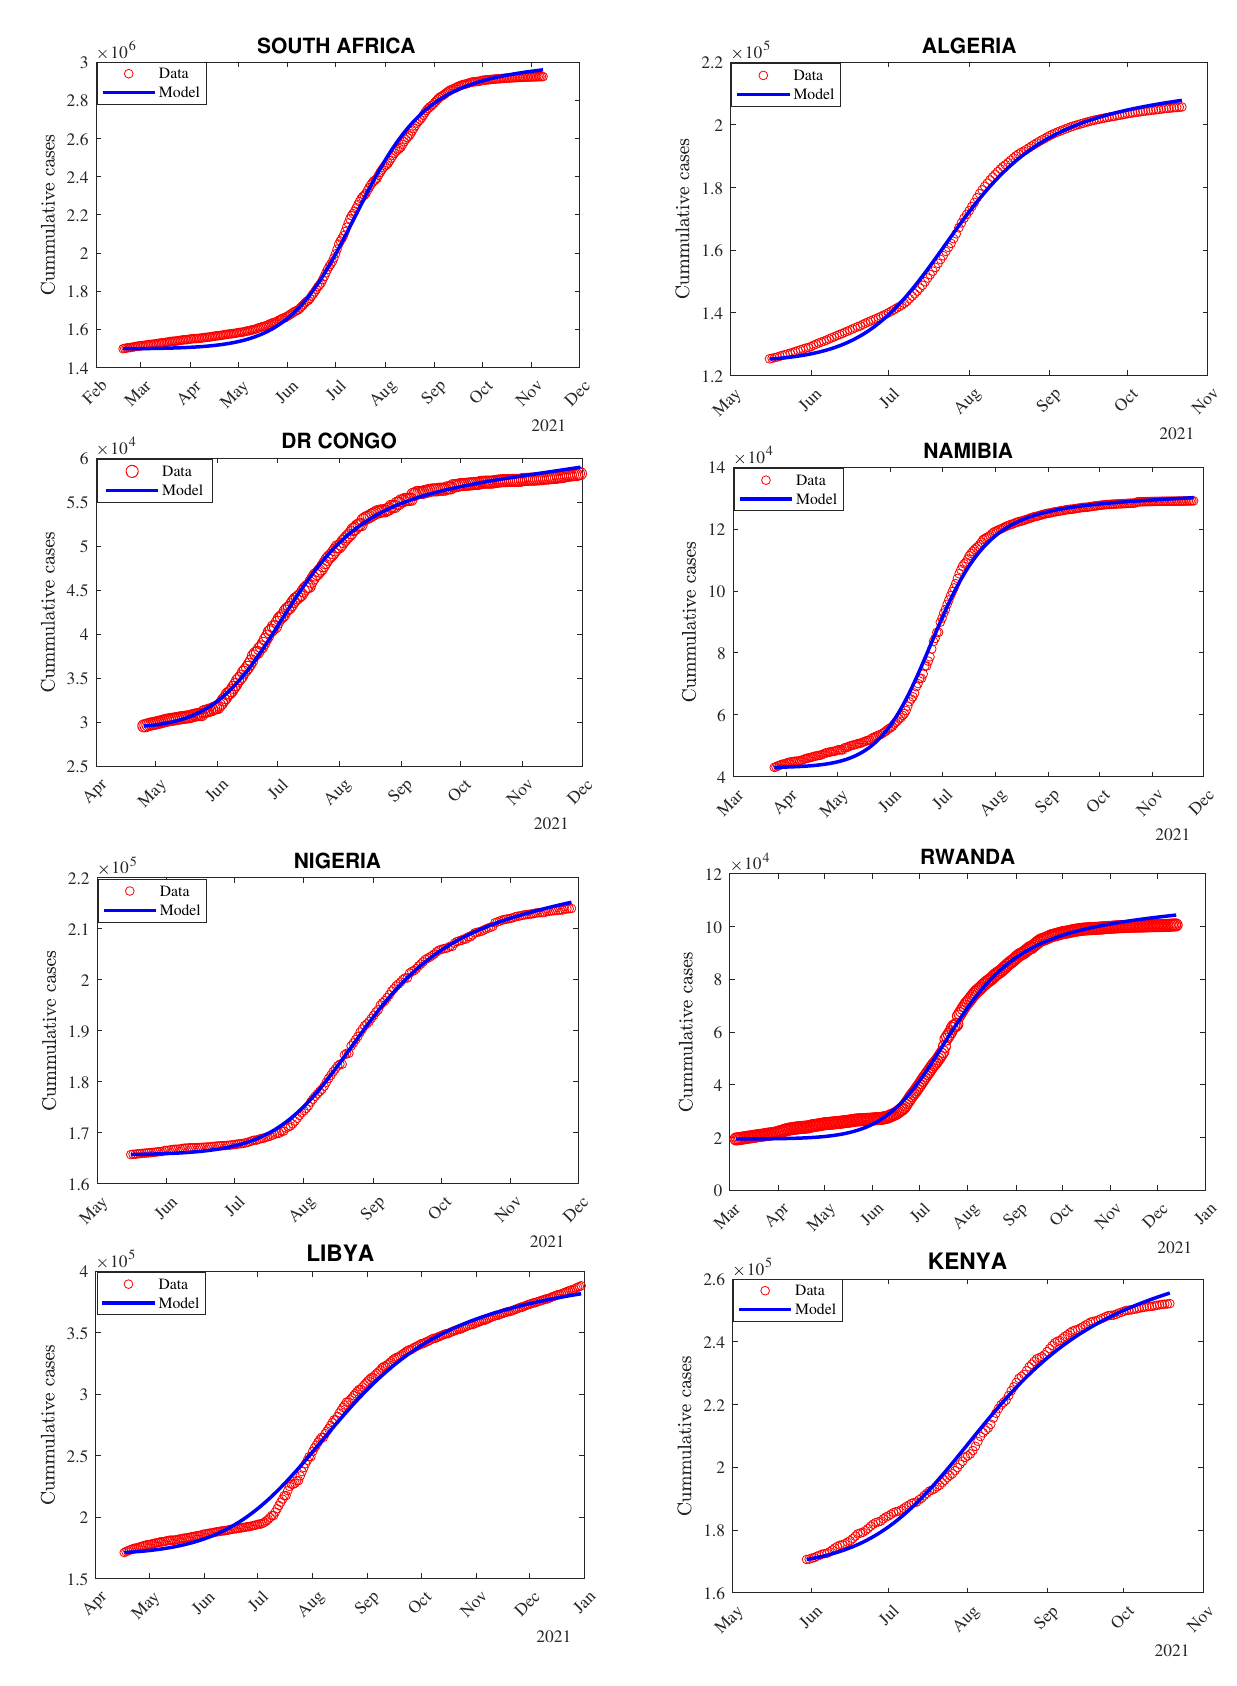
Figure A1. Plots depicting the fitting of the model to the cumulative confirmed COVID-19 cases for selected African